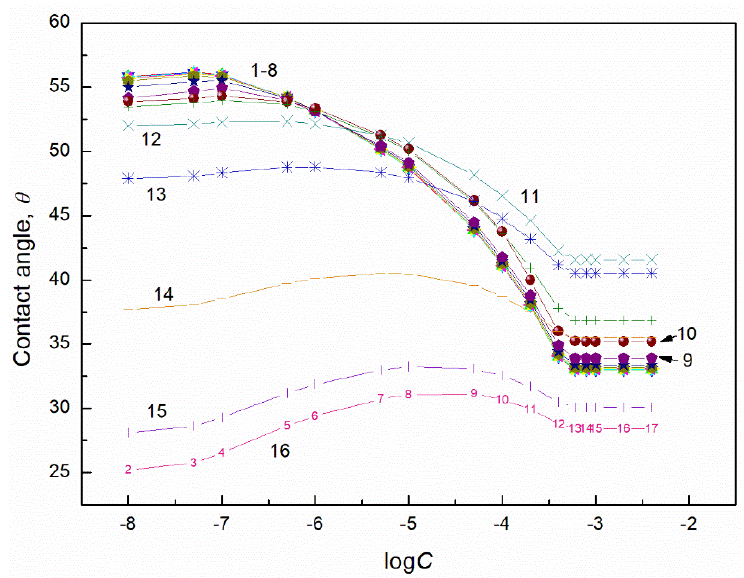
Figure 7. A plot of the contact angle ( θ ) of aqueous solution of TX165 + RL mixtures on the quartz surface vs. the logarithm of the TX165 concentration ( C ). Curves 1 – 16 correspond to the constant RL concentration equal to 0.0002, 0.0005, 0.00125, 0.003, 0.00625, 0.01, 0.02, 0.05, 0.1, 0.5, 1, 5, 10, 20, 30 and 40 mg/dm 3 , respectively.